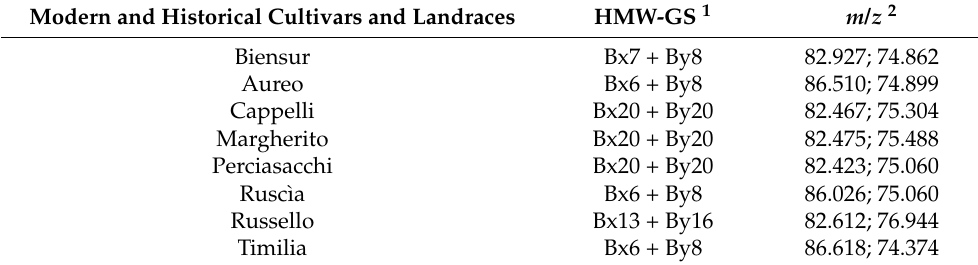
Table 3. HMW-GS profiles assigned to the reference seeds of landraces and historical cultivars both with SDS-PAGE profiles in comparison with commercial durum wheat varieties and by MALDI- TOF/MS analyses.